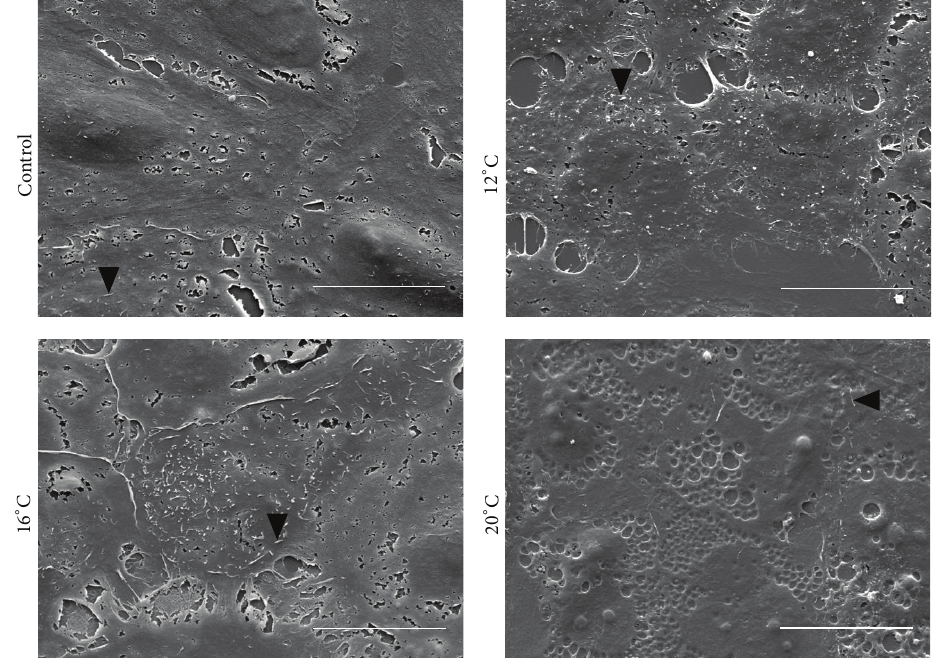
Figure 6: Scanning electron photomicrographs showing apical microvilli on control ARPE-19 cells as well as on cells subjected to seven days of storage at 12 ∘ C, 16 ∘ C, and 20 ∘ C. Scale bars: 20 𝜇 m. Black arrowheads: microvillus.